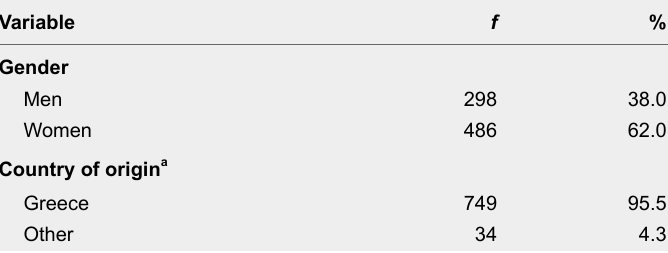
Sociodemographic Characteristics of the Sample (N = 784)